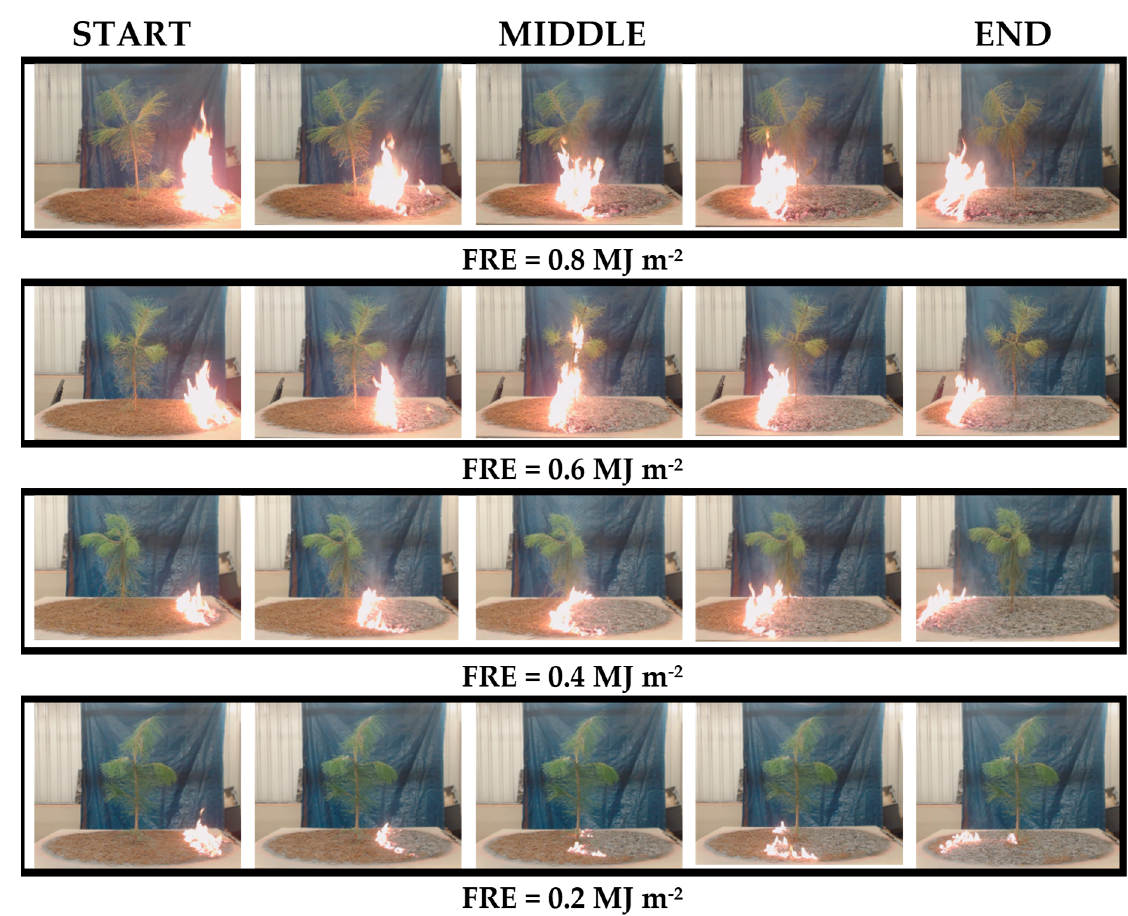
Figure 1. Time-lapse video images for representative saplings undergoing surface fires of